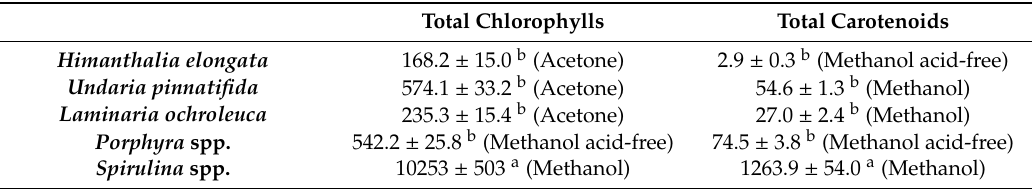
Table 2. Total chlorophylls and carotenoids contents and best extraction solvent for the analyzed samples (results expressed in µ g / g of algae).